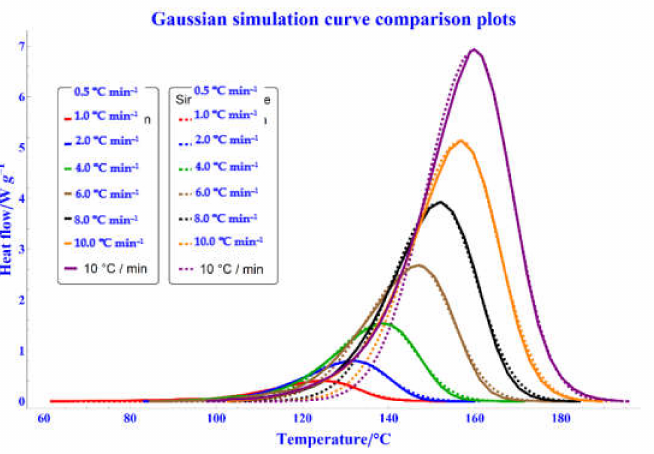
Figure 8. Gaussian simulation curve and DSC measurement curve comparison